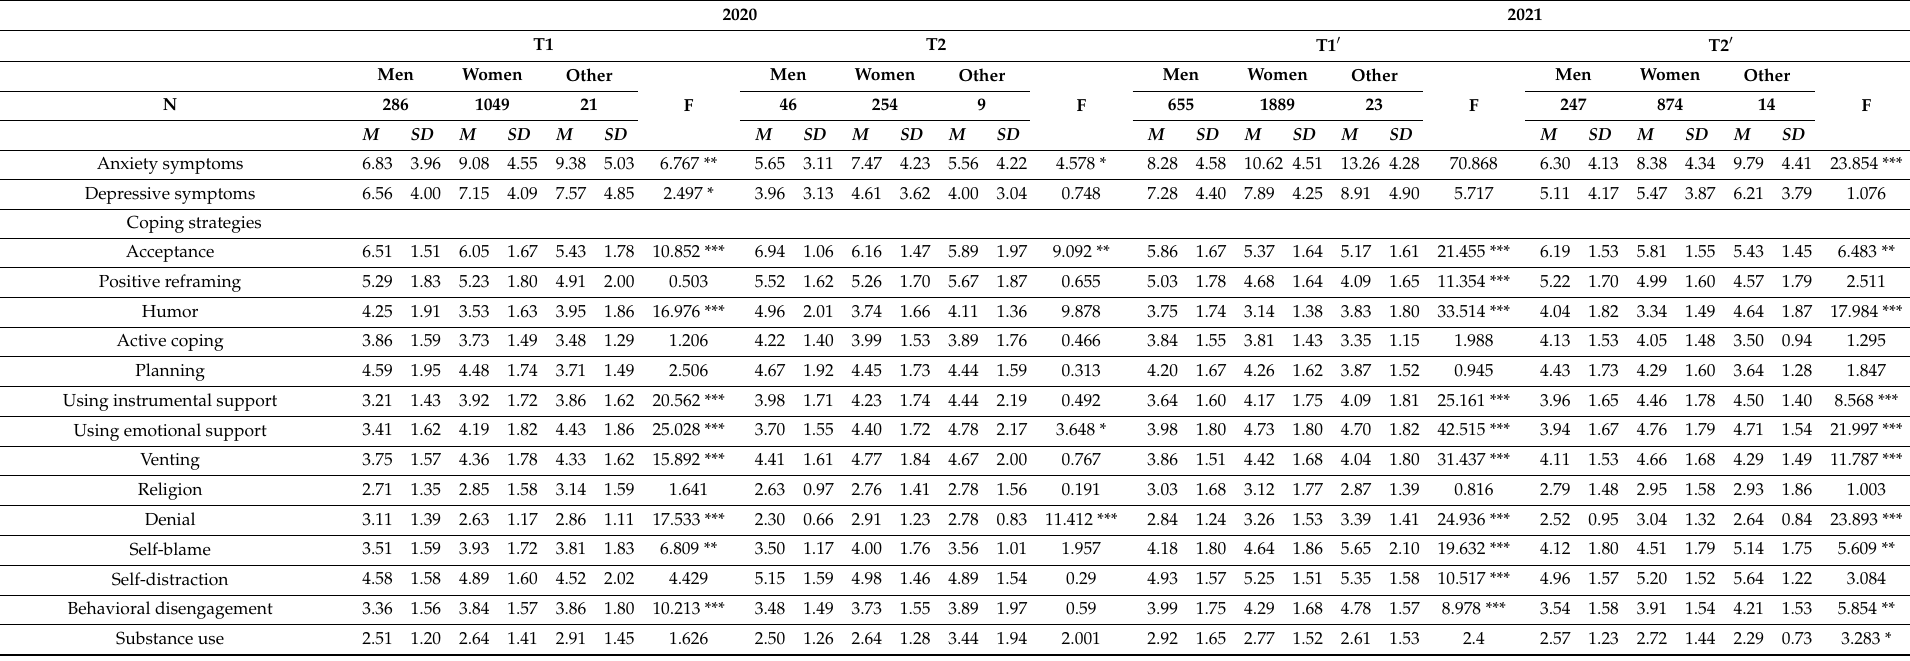
Table 1. Means (and standard deviations) by gender at four time points and means